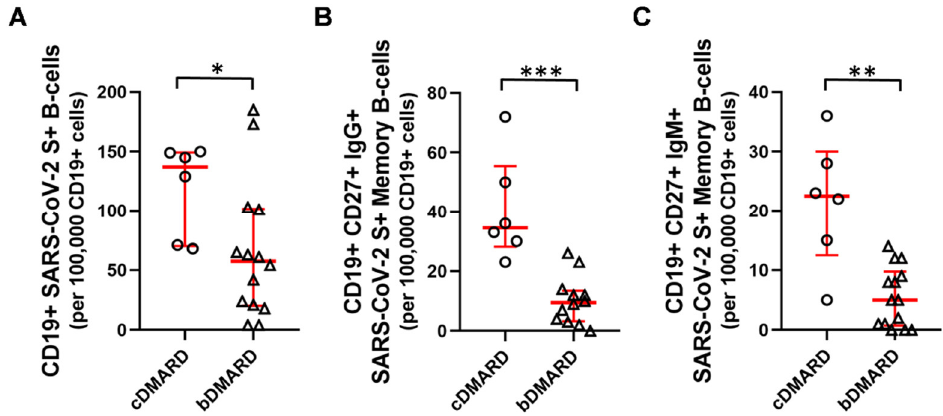
Figure 5. The proportion of CD19+ SARS-CoV-2 S+ B-cells ( A ), IgG+ ( B ), or IgM+ ( C ) SARS-CoV-2 S antigen reactive memory (CD19+CD27+) B-cells within patients receiving a homologous booster split according to their medication. Horizontal lines—median, whiskers—interquartile range. (circles: cDMARD n = 6, triangles: bDMARD n = 15). * p < 0.05; ** p < 0.01; *** p < 0.001.